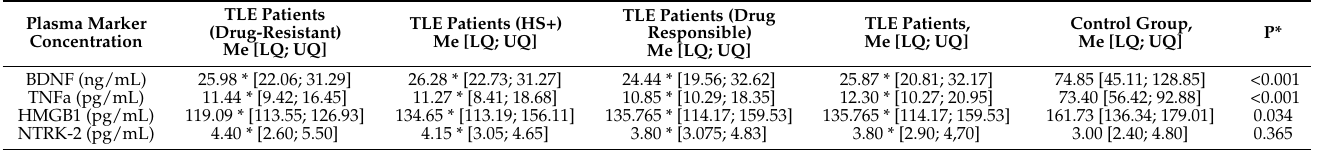
Table 2. The significant alteration in the concentrations of markers of neuroinflammation and neurodegeneration in the blood plasma of patients in the TLE and control groups. TLE Patients Plasma Marker Concentration